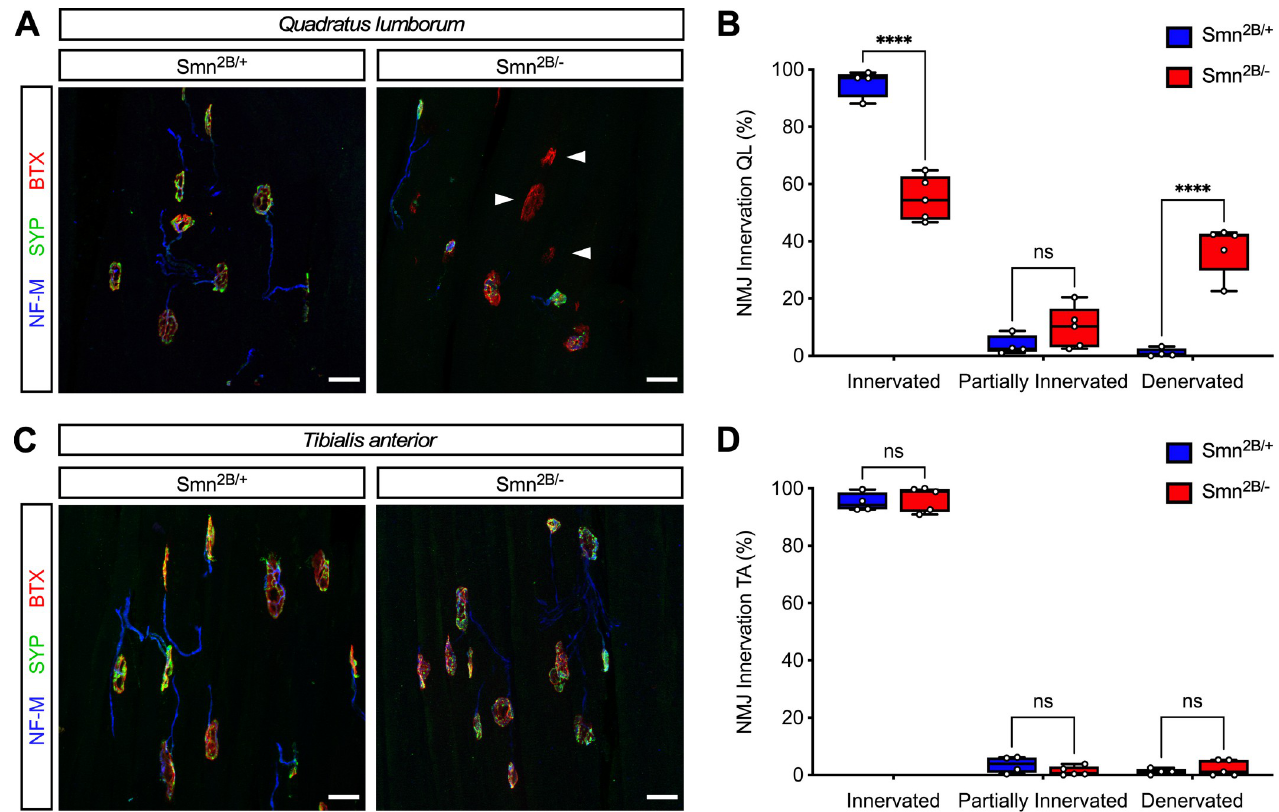
Fig 3. Selective loss of NMJ innervation in axial but not distal muscles in Smn 2B/- SMA mice. (A and C) NMJ staining with bungarotoxin (BTX), Synaptophysin (SYP), and Neurofilament-M (NF-M) of the axial muscle quadratus lumborum (A) and the distal muscle tibialis anterior (C) from control ( Smn 2B/+ ) and SMA ( Smn 2B/- ) mice at P16. Arrowheads indicate denervated NMJs. Scale bars: 25 μ m. (B and D) Percentage of fully innervated, partially innervated, and denervated NMJs from the same groups as in (A) and (C). The box-and-whiskers graph shows the individual values, median, interquartile range, minimum and maximum from Smn 2B/+ (n = 4) and Smn 2B/- (n = 5) mice. Statistics were performed with two-tailed unpaired Student’s t-test. ���� P < 0.0001, ns = not